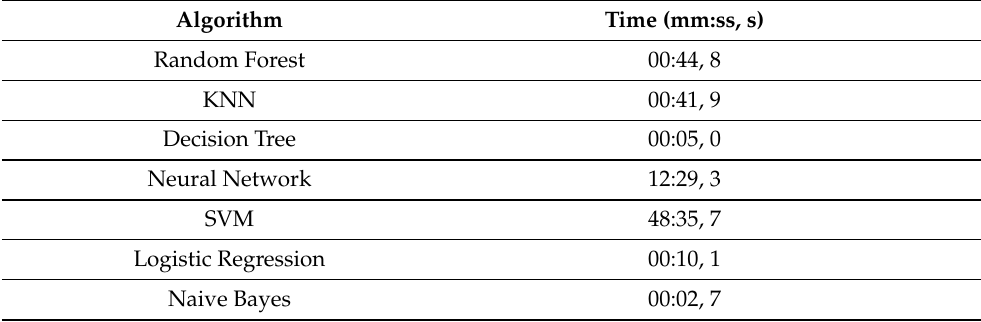
Table 4. Raspberry PI learning times.